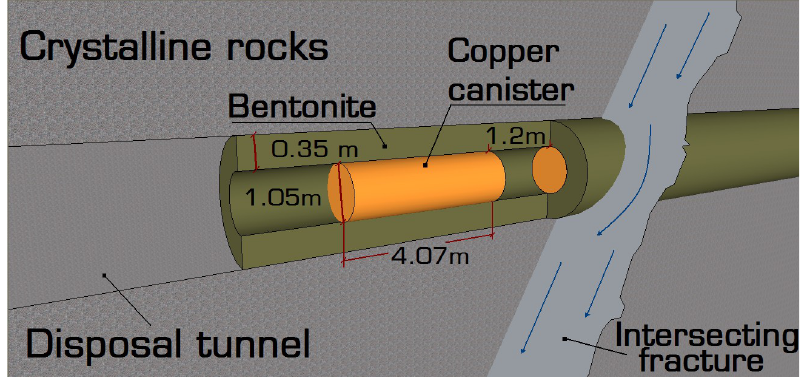
Figure 1. Dimensions of the engineered barriers of repository [21].